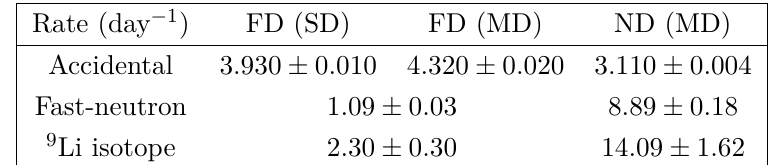
Figure 1 . IBD candidates (black dots) as a function of the visible energy above 8.5 MeV, extracted from reactor-on data in the FD (left) and the ND (right). The expected contribution from fast- neutrons is shown with dashed line and yellow error band. The fast-neutron subtraction in the 8.5–12 MeV range provides the number of 9 Li decays which is used to extrapolate the total rate below 8.5 MeV.